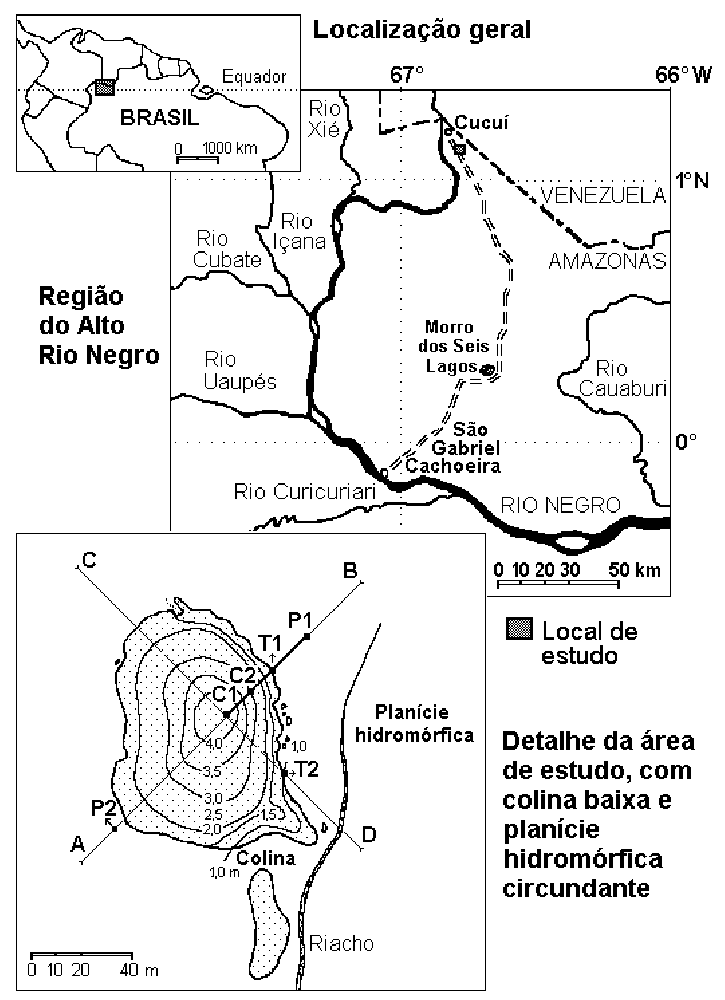
Figura 1. Localização da área de estudo na região do alto rio Negro, nas proximidades de Cucuí, AM, às margens da rodovia BR 307, com detalhe da colina estudada, mostrando os alinhamentos AB e CD e as curvas de nível eqüidistantes em 0,5